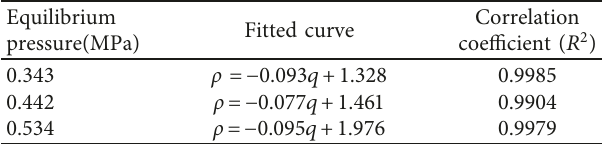
Table 4: Fitting results of relationship between resistivity of coal and gas content in the continuous desorption